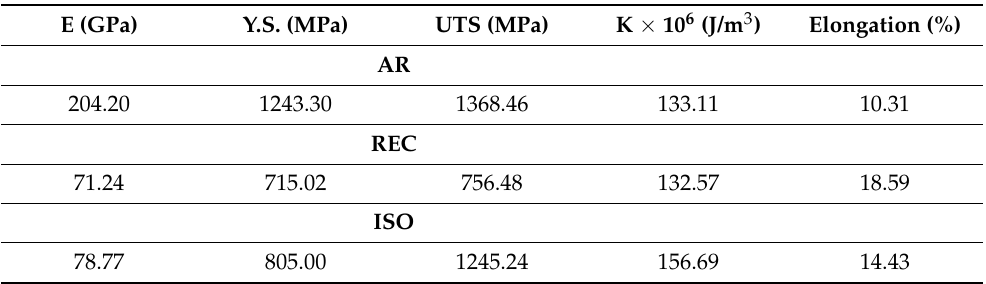
Figure 11. Tensile test graphs of the samples. Table 7. Parameters obtained from the tensile test: E—Elastic modulus, Y.S.—Yield strength, U.T.S.— Ultimate tensile strength and